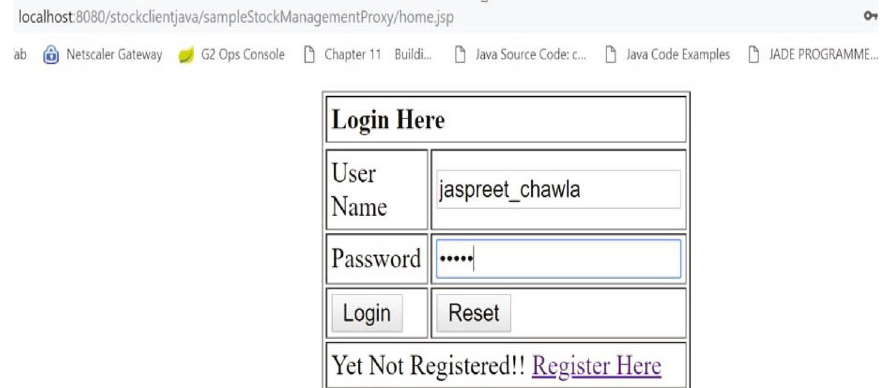
Figure 4: Testing of user authentication